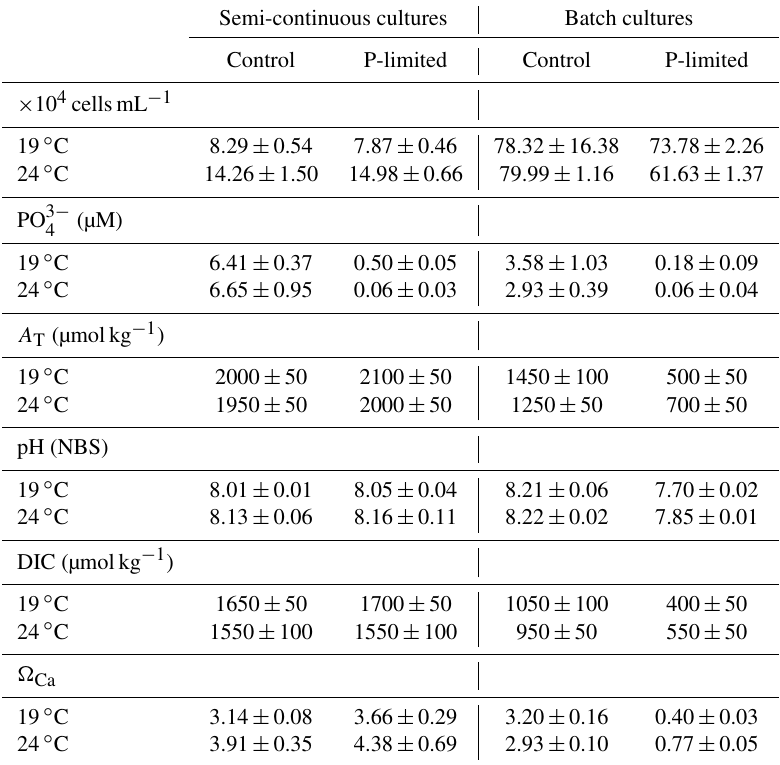
Table 5. Cell concentrations, residual phosphate, A T , pH, DIC and (cid:127) Ca in the culture media at the time of harvest of semi-continuous and batch control and P-limited cultures of Emiliania huxleyi grown at 19 and 24 ◦ C; n = 3 ± standard